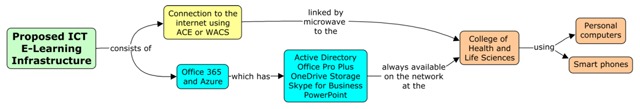
Proposed E-learning Infrastructure.